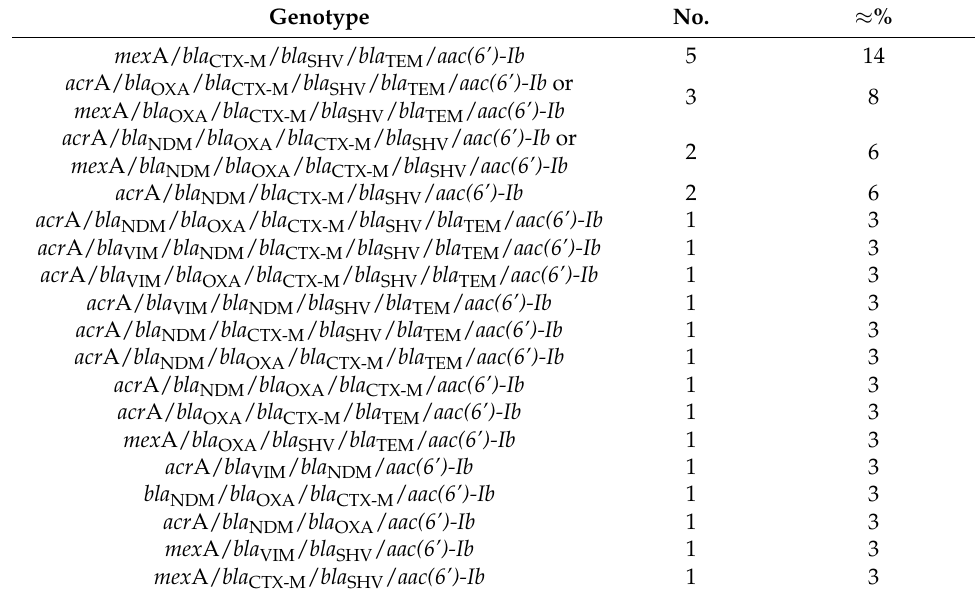
Table 3. Antimicrobial resistance genotypes of CRGNPs (n = 34)